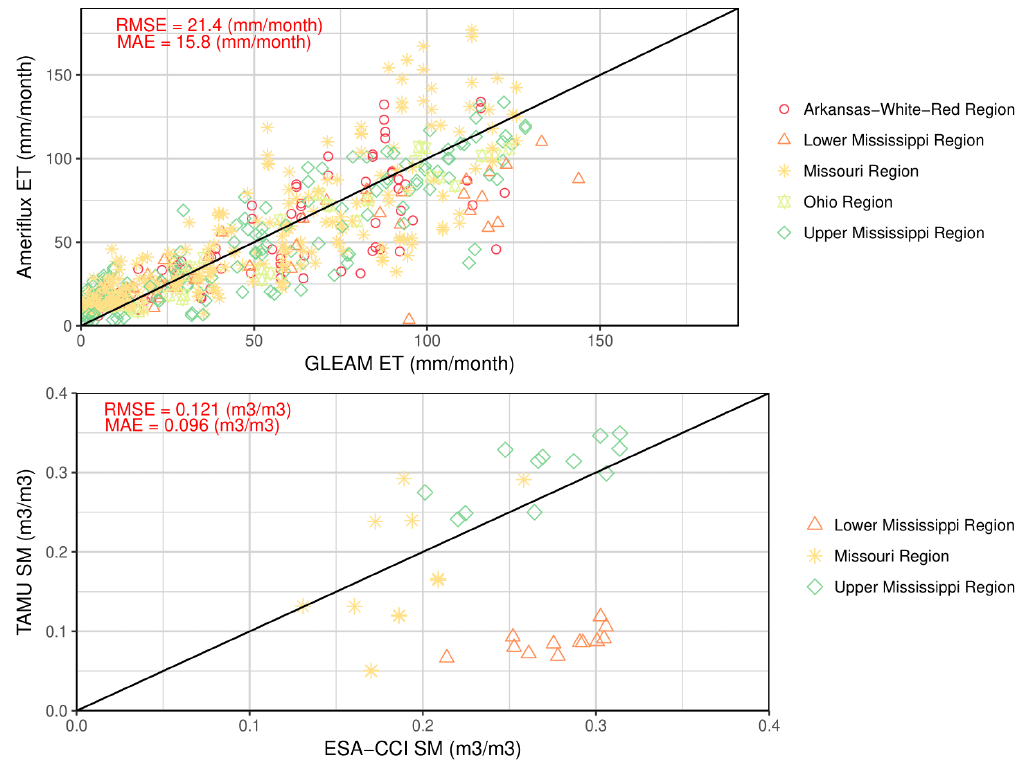
Figure A1 . Scatter plots of a) GLEAM ET vs. Ameriflux measurements (top panel) and b) ESA–CCI soil moisture vs. TAMU NASMDB measurements (bottom panel) for 2004. RMSE and the Mean Absolute Error (MAE) values are indicated in red.